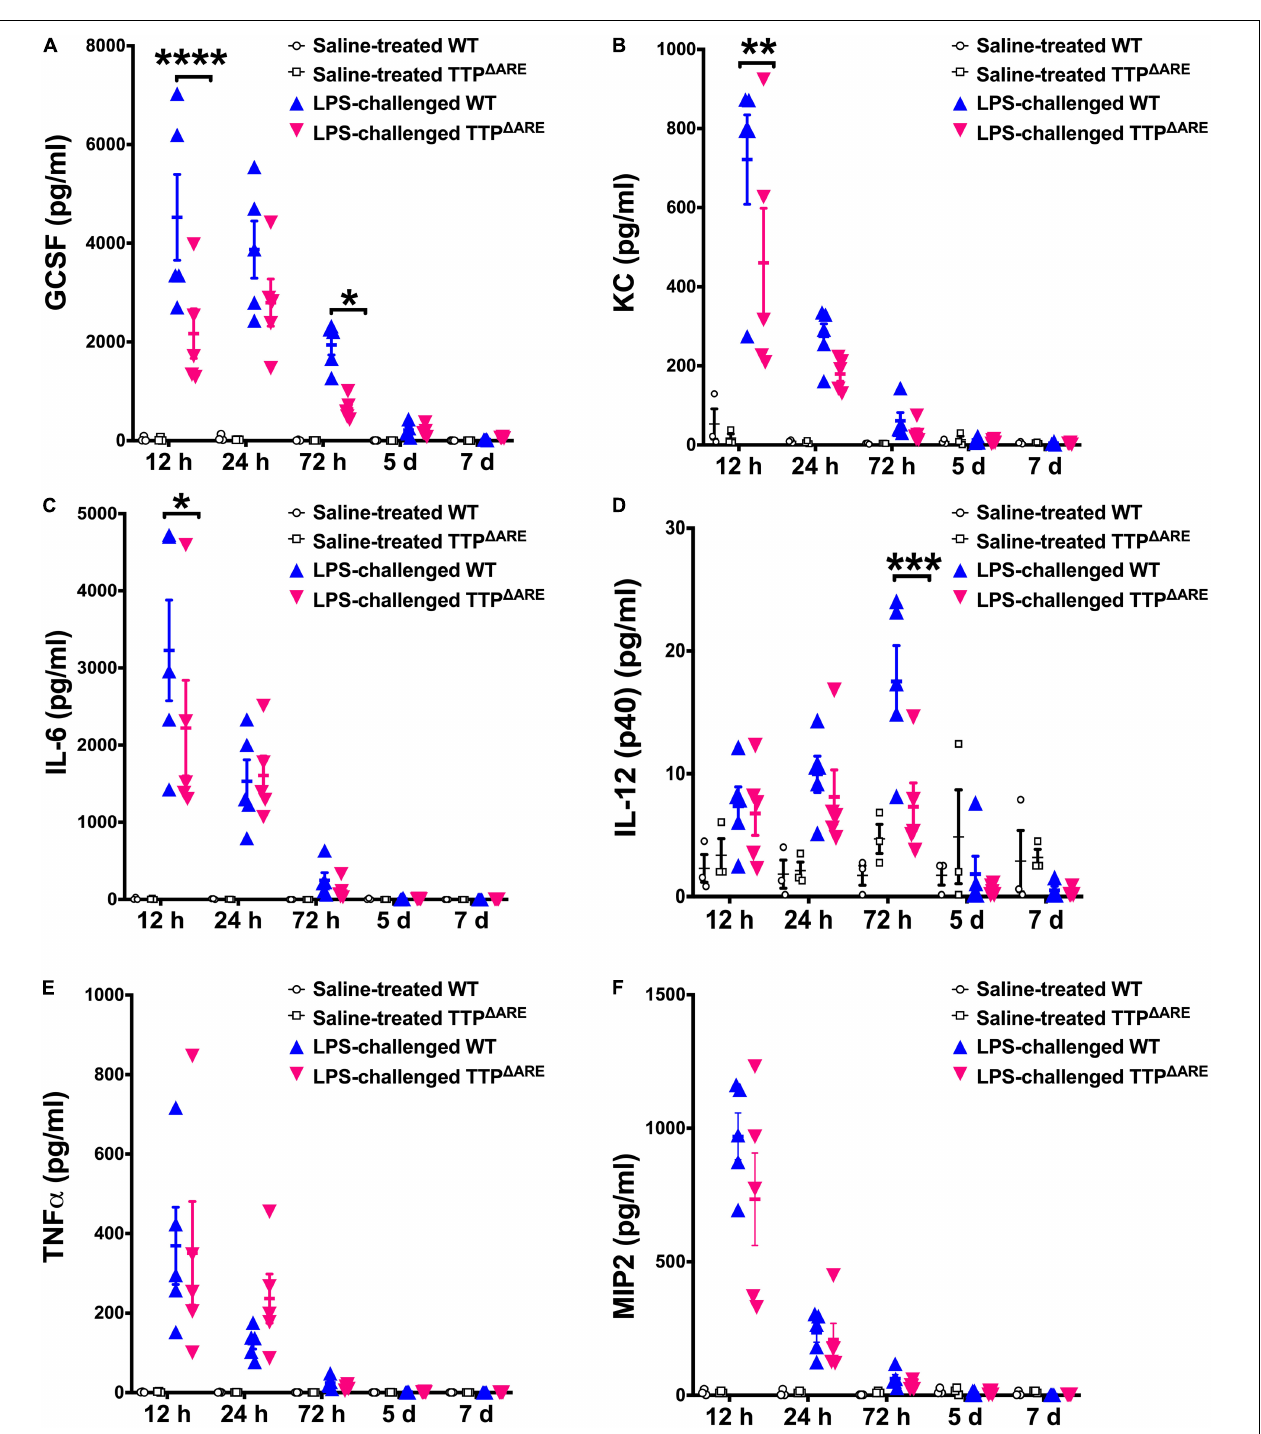
FIGURE 4 | BALF levels of key pro-inflammatory cytokines and chemokines are significantly reduced in TTP overexpression mice compared to WT control mice. Levels of G-CSF (A) , KC (B) , IL-6 (C) , IL-12 (p40) (D) , TNF α (E) , and MIP2 (F) in the BALF from adult WT and TTP (cid:49) ARE mice are shown. Saline-treated WT (open circles), saline-treated TTP (cid:49) ARE (open squares), LPS-challenged WT (closed blue triangles), and LPS-challenged TTP (cid:49) ARE (closed magenta triangles). Statistical analysis was performed by two-way ANOVA followed by Tukey’s correction for multiple comparisons. Data are represented as mean ± SEM. N = 3 (WT and TTP (cid:49) ARE saline control); N = 5 (WT and TTP (cid:49) ARE LPS). * p < 0.05, ** p < 0.01, *** p < 0.001, **** p < 0.0001.